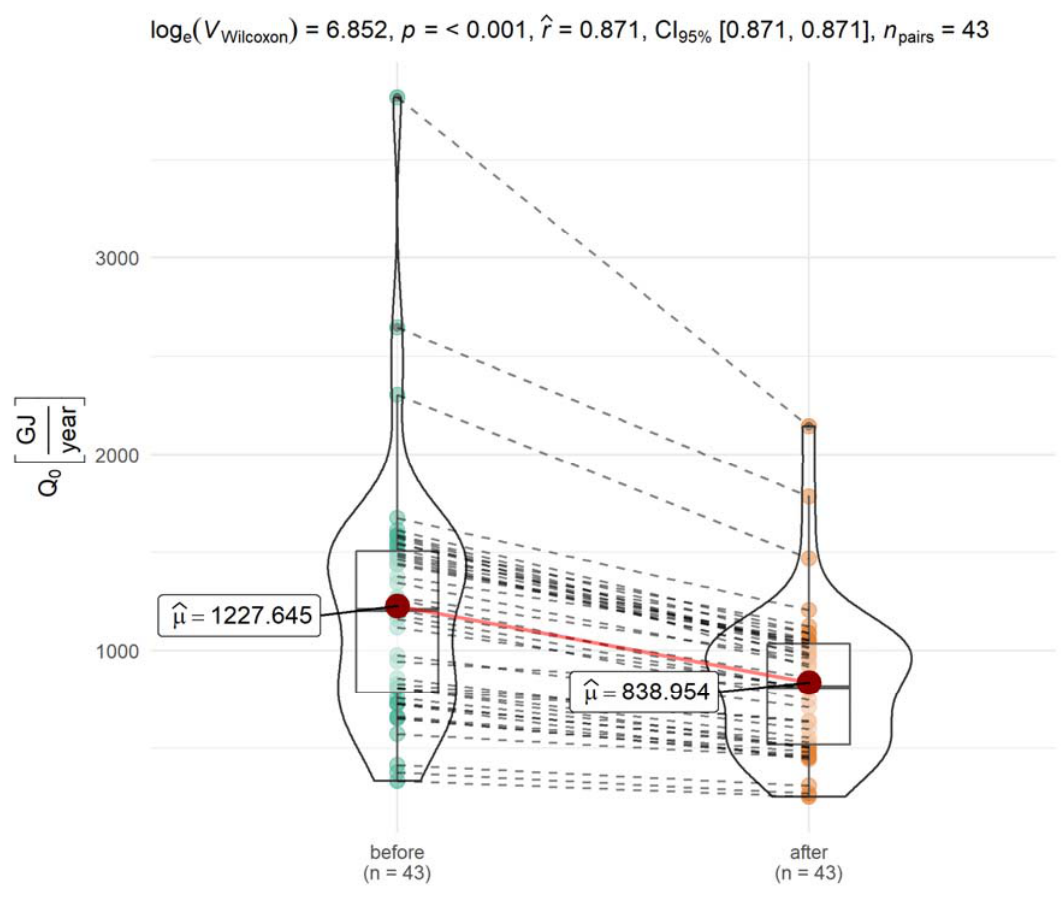
Figure 1. Comparison of corrected annual energy consumption before and after retrofitting.